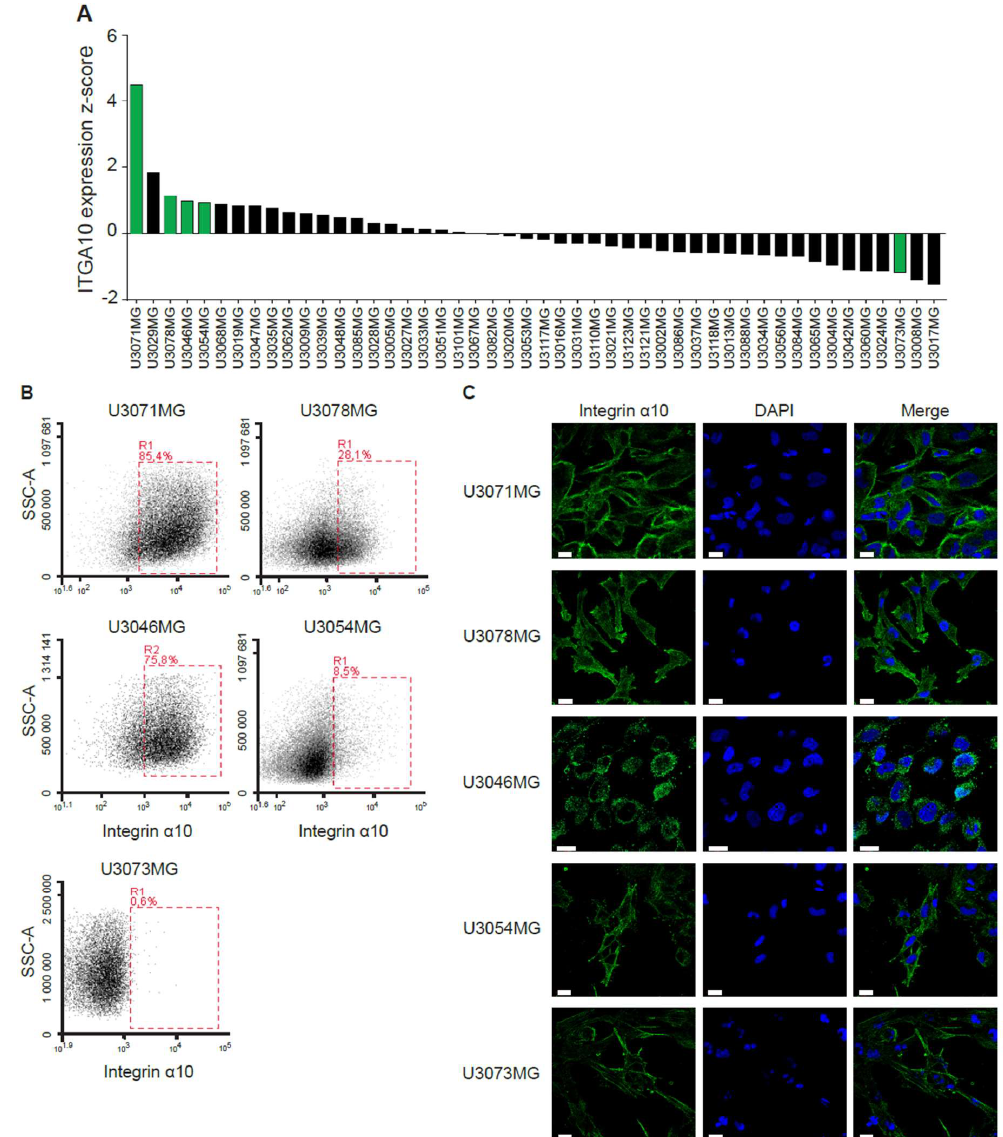
Figure 2. Integrin α10 is expressed in patient-derived GBM cell lines. ( A ) ITGA10 gene expression from the Human Glioblastoma Cell Culture (HGCC) database, including 48 cell lines plotted as z-scores. Cell lines marked with green color were selected for further characterization. ( B , C ) Detection of integrin α10 protein expression on patient-derived GBM cell lines U3071MG, U3078MG, U3046MG, U3054MG, and U3073MG. ( B ) Flow cytometry profiles of integrin α10 and the fluorescence intensity of cells labeled with the antibody directed against α 10 plotted against side scatter. ( C ) Immunofluorescence analysis of labeled integrin α 10 protein, 4 (cid:48) ,6-diamidino-2-phenylindole (DAPI) staining of cell nuclei and a merged image (Merge). Scale bars represent 20 µ